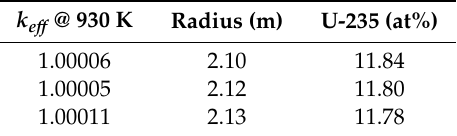
Figure 3. Criticality of the 2D system over burnup for different system radii for the close to eutectic composition 45%NaCl-38.5%UCl 4 -16.5%UCl 3 . Table 3. Data (initial criticality and required uranium 235 enrichment) for the dimensional iteration for the averaged fuel temperature of 930 K for the close to eutectic